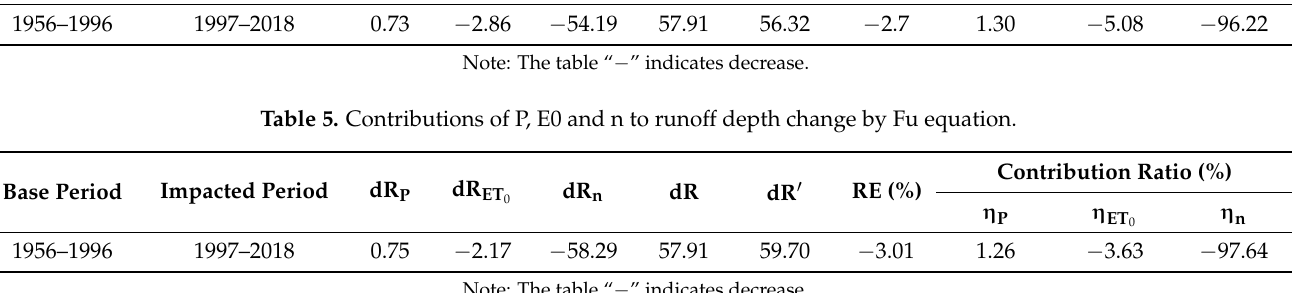
Figure 7. Elasticity coefficients for the n parameter for the three Budyko methods from 1956 to 2018. Table 4. Contributions of P, ET0 and n to runoff depth change by Wang and Tang equation. Base Period